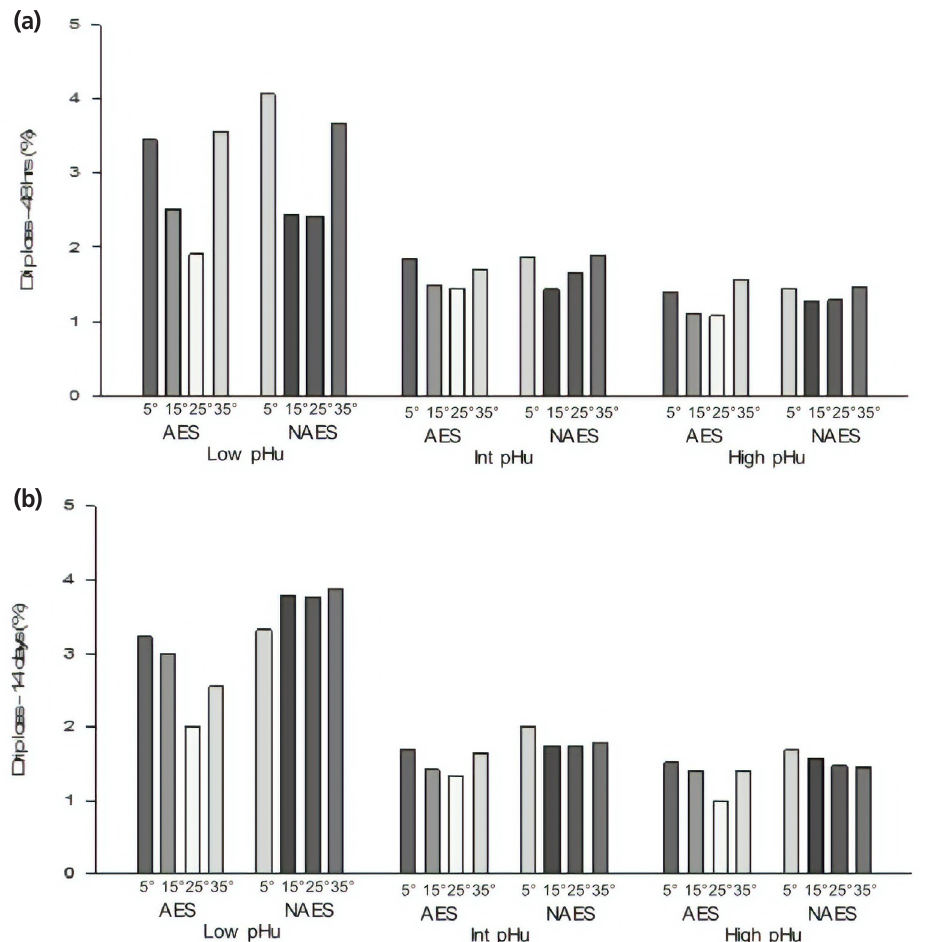
Figure 6. (a) Effect of AES and various pre-rigor holding temperature (for 3 h) methods on drip loss (48 h post mortem) of low, intermediate and high pHu beef M. longissimus lumborum samples. AES, additional electrical stimulation; NAES, no additional electrical stimulation. Low pHu (n = 3), Int (intermediate) pHu (n = 3), and high pHu (n = 6). Treatment effect [AES vs ES] (p>0.05); pH effect (p<0.001); temperature effect (p<0.001); interaction effect (pH×temperature) (p = 0.015, standard error of difference [SED] = 0.17). (b) Effect of AES and various pre-rigor holding temperature (for 3 h) methods on drip loss (14 days post mortem) of low, intermediate and high pHu beef samples. Low pHu (n = 3), Int (intermediate) pHu (n = 3), and high pHu (n = 6). Treatment effect [AES vs ES] (p<0.008); pH effect (p<0.001); temperature effect (p = 0.003); interaction effect (stimulation×temperature) (p = 0.015); (stimulation×temperature×pH) (p = 0.036, SED =